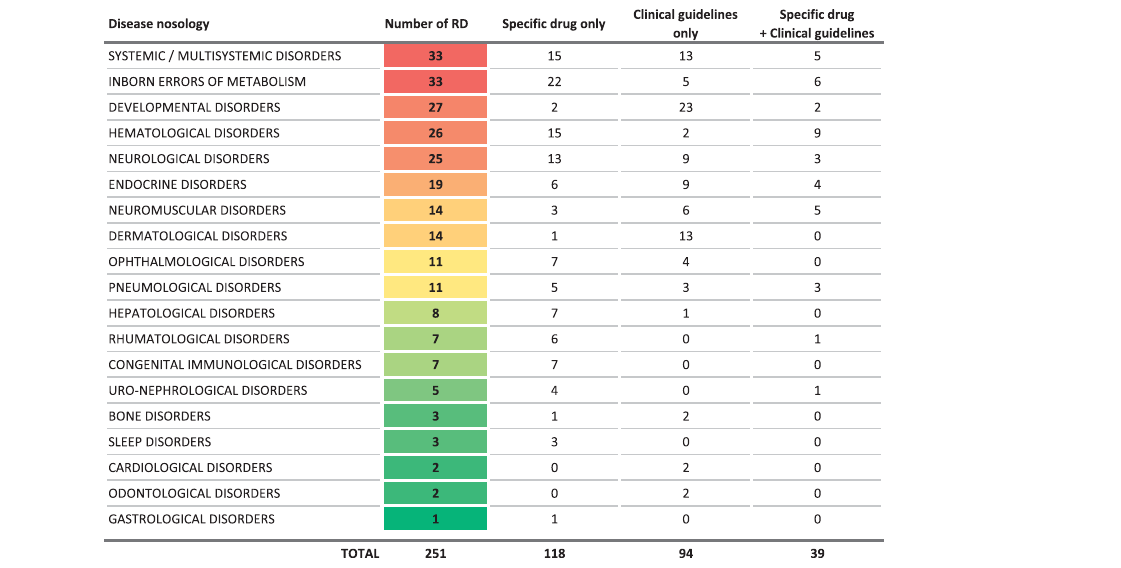
TABLE 2 | Distribution of care management options by broad groups of diseases.